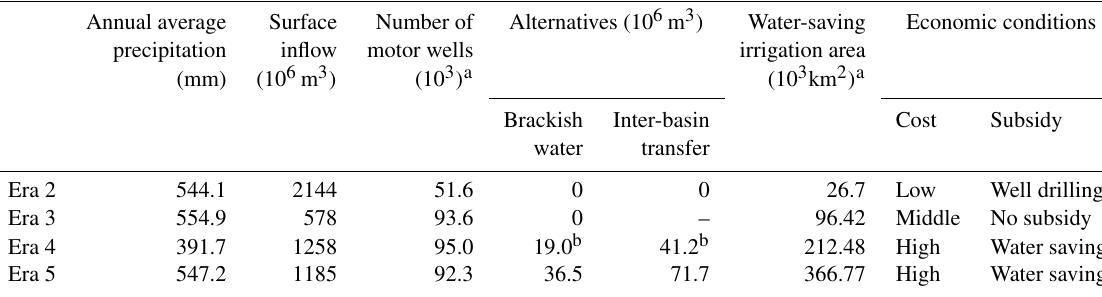
Table 3. Changes in natural variability and social drivers from Era 2 to Era 5. Annual average